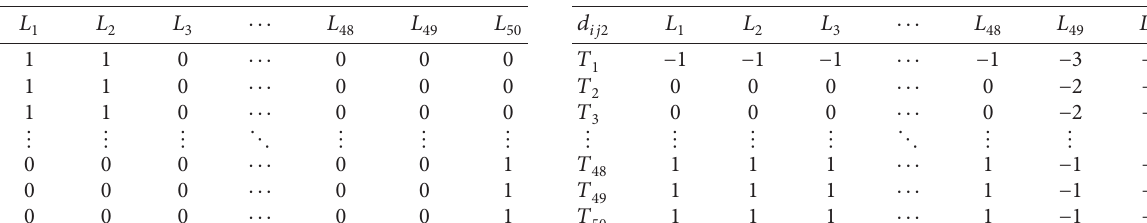
� [ a ] for landlords’ ij 1 1 50 × 50